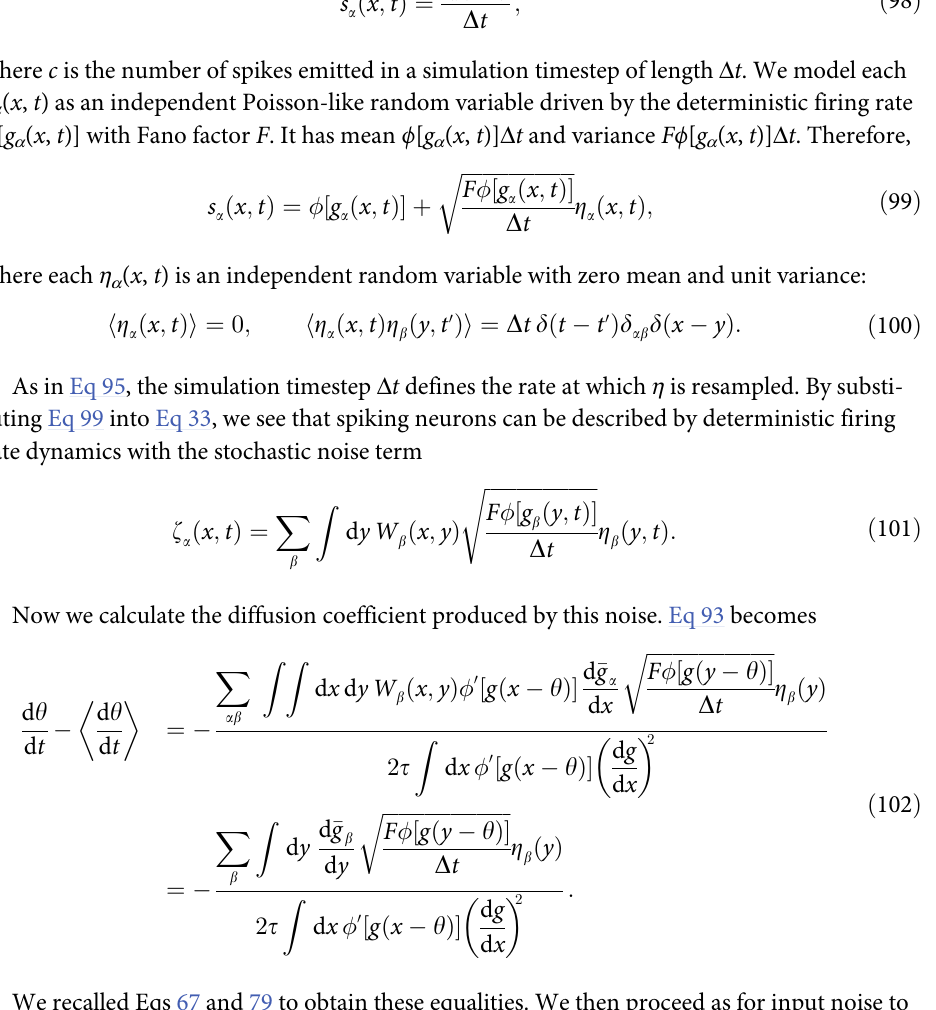
ffiffiffiffiffiffiffiffiffiffiffiffiffiffiffiffiffiffiffiffiffiffi ð x ; t Þ� F � ½ g a